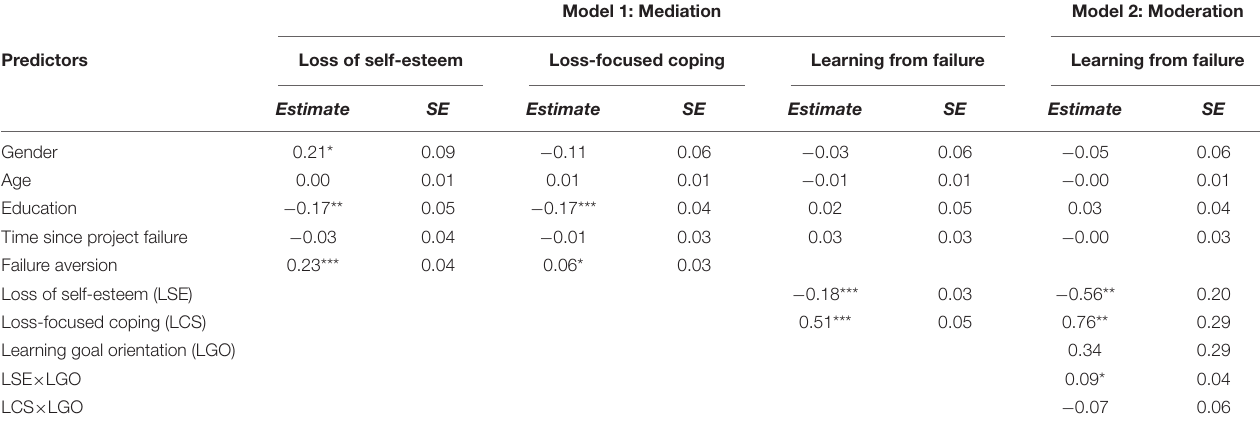
TABLE 3 | The results of hypothesis test.